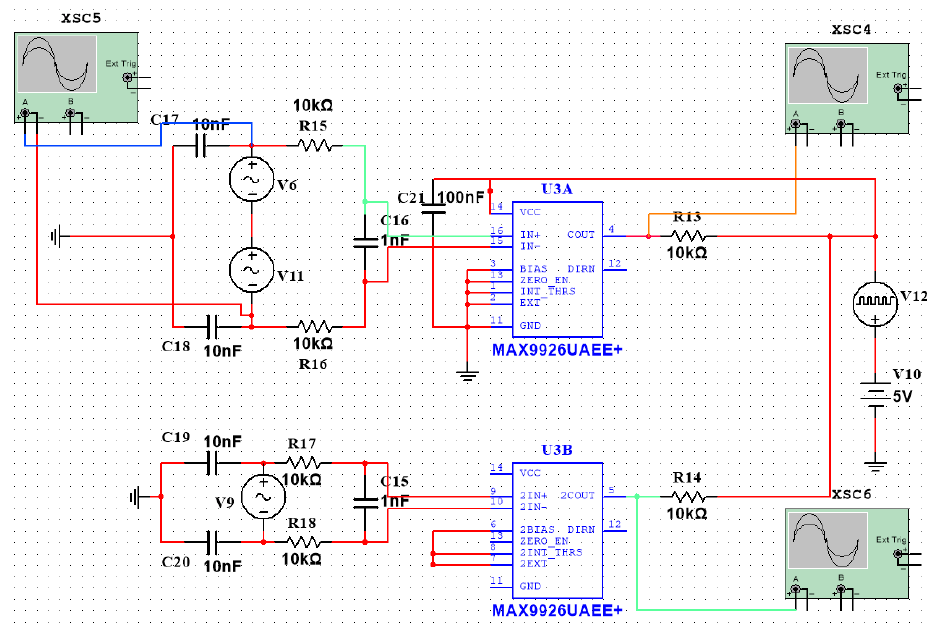
Figure 11. Error analysis of the numerical model.